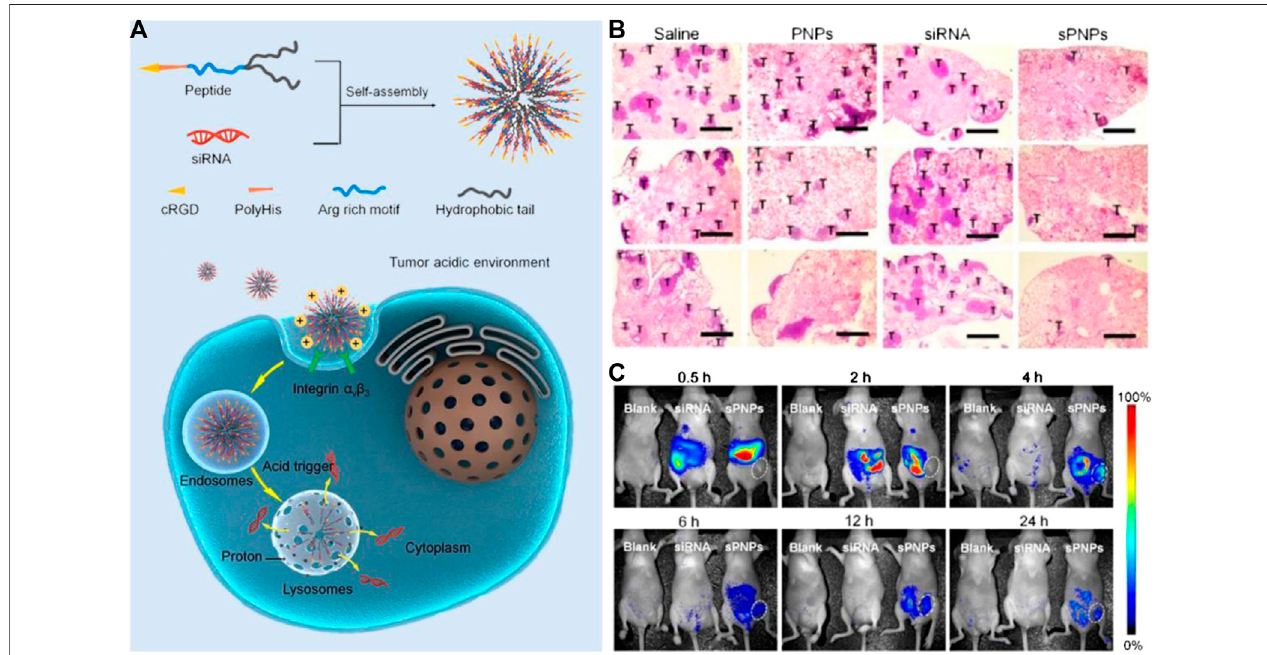
FIGURE 3 | (A) Schematic of the self-assembly of the sPNPs nanoparticles and their antitumor mechanism. (B) Effects of PNP, free TF siRNA, and sPNPs on metastasis in 4T1 tumor bearing mice. (C) In vivo fl uorescence imaging of MDA-MB-231 tumors bearing mice after administration of nothing (left) , free Cy5-siRNA (middle) , or Cy5-sPNPs (right) . Reproduced with permission from Liu S. et al. (2019). Copyright 2019 American Chemical Society.